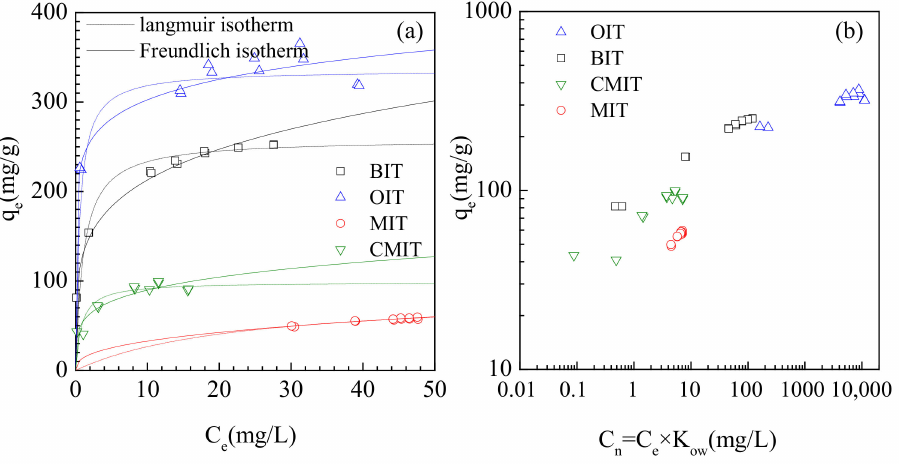
Figure 3. Adsorption isotherm curves of isothiazolones on PAC ( a ) and hydrophobicity (K ow ) modified adsorption isotherm curves ( b ). Conditions: shaking frequency 100 rpm, temperature 298 K, pH =